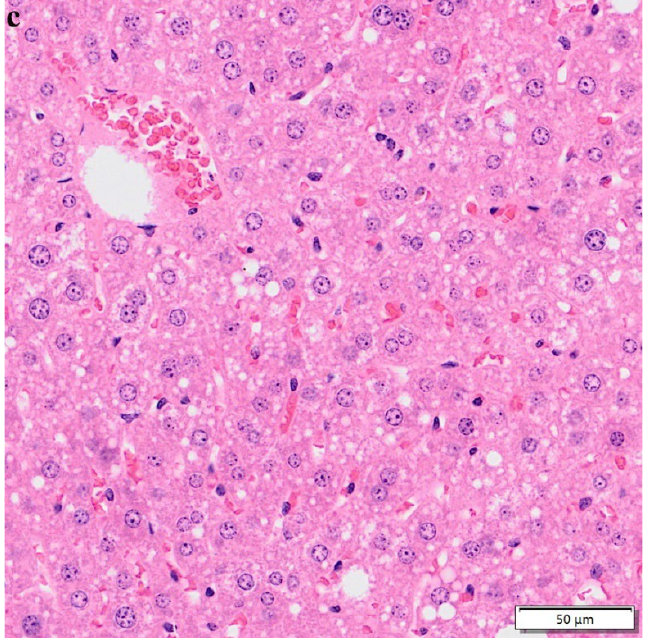
Figure 7. HE staining of the liver sections: ( a ) control group; ( b ) high-fat diet group; ( c ) high-fat diet + lycopene group. Magnification 200×.